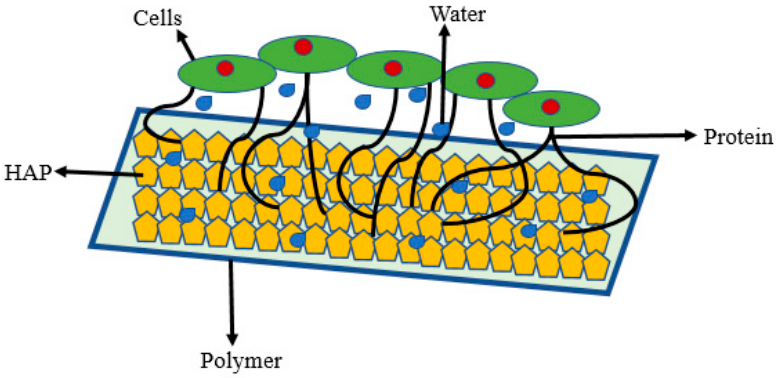
Figure 12. Schematic representation of HA–protein–cell interactions in ECM.